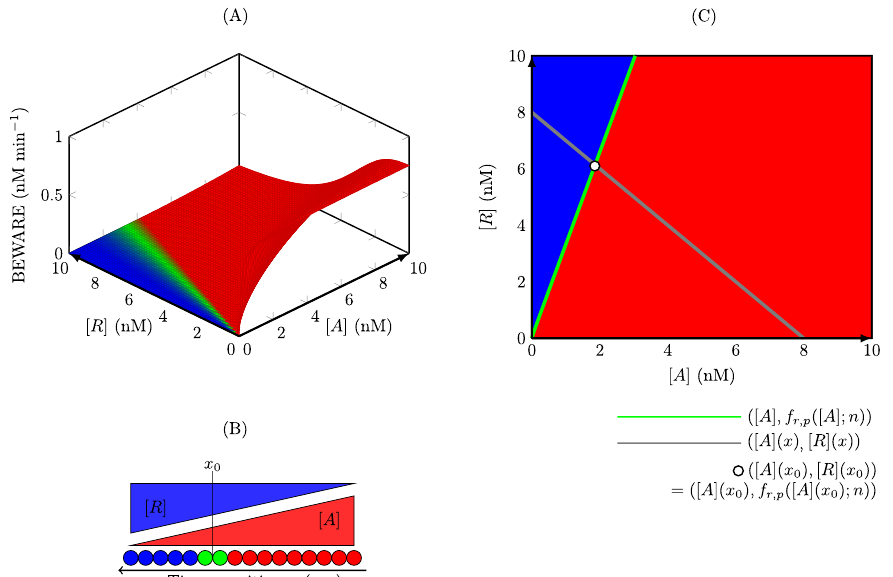
Figure 2. Activation-repression threshold and net activated/repressed tissular regions. ( A ) BEWARE operator representation. Blue, green and red correspond to values of the BEWARE operator, lower than, close to or higher than the basal level. ( B ) Triangles represent the tissular activator/repressor gradients governing gene transcription. Lower circles show net activated/repressed tissular regions determined by the upper gradients and the BEWARE operator in ( A ). The limiting position, x 0 corresponds to cells that have TF concentrations determined by the white circled in figure ( C ); ( C ) representation of ( A , B ) in the [A]–[R] plane. The blue region is concentrations leading to BEWARE values below the basal level. The red region is concentrations leading to BEWARE values above the basal level. The green curve is the activation/repression threshold, that is, concentrations leading to the basal level. The grey curve shows the TF concentrations represented by the triangles in ( B ). The intersection between the green and grey curves, i.e., white circle, determines tissular regions where cells are net activated or repressed according to the BEWARE operator. Parameter values can be found in Supplementary Materials Table